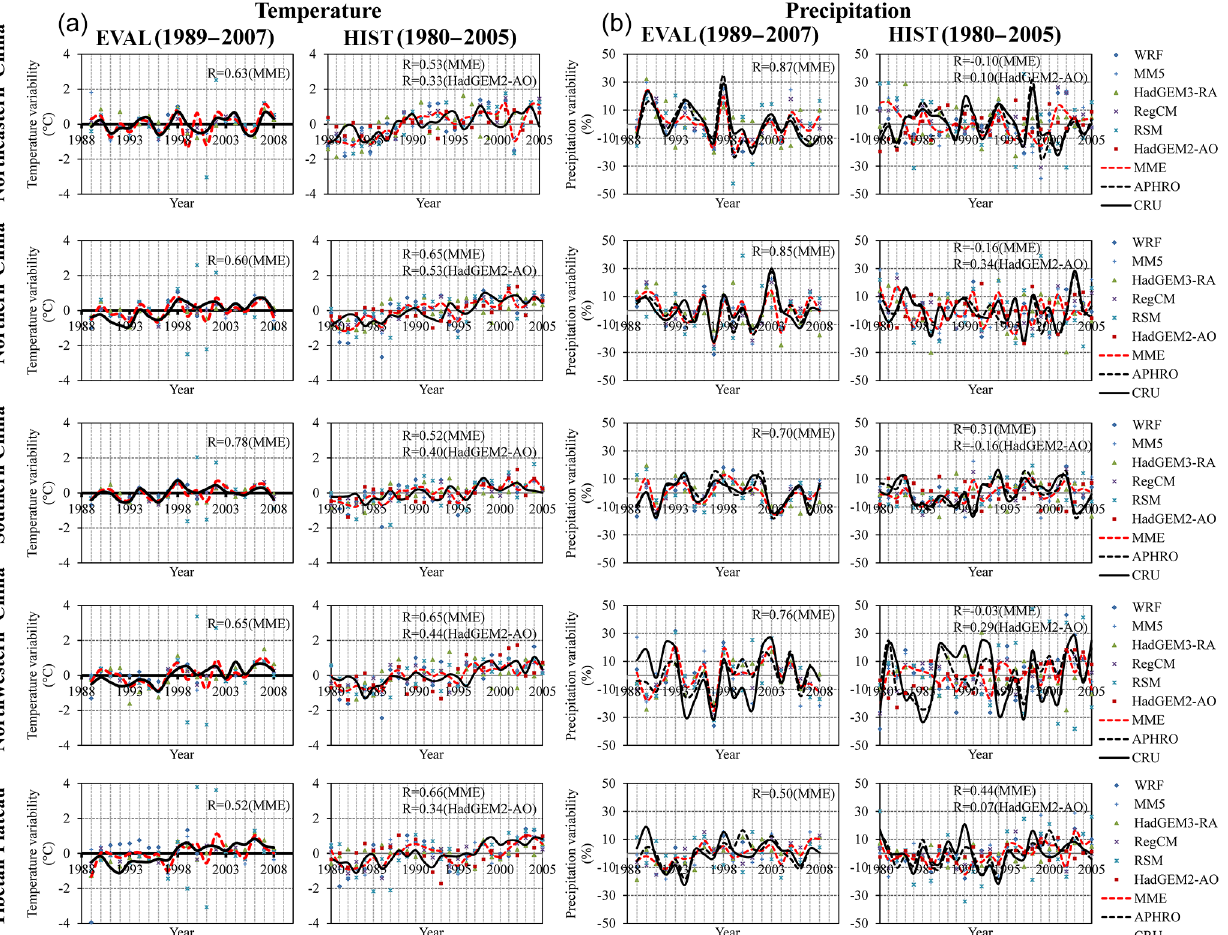
Figure 5. Temporal evolution of the annual mean temperature (a) and precipitation (b) in RCM simulations and observations over the five subregions during the 1989–2008 (EVAL) and 1980–2005 (HIST) periods. The correlation coefficients between the ensemble of RCMs and the observations are shown at the top right of each